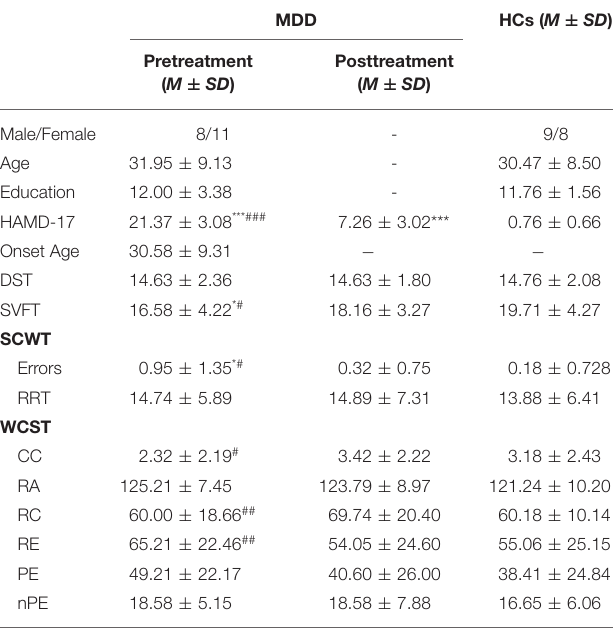
TABLE 1 | Demographic and clinical characteristic of MDD and